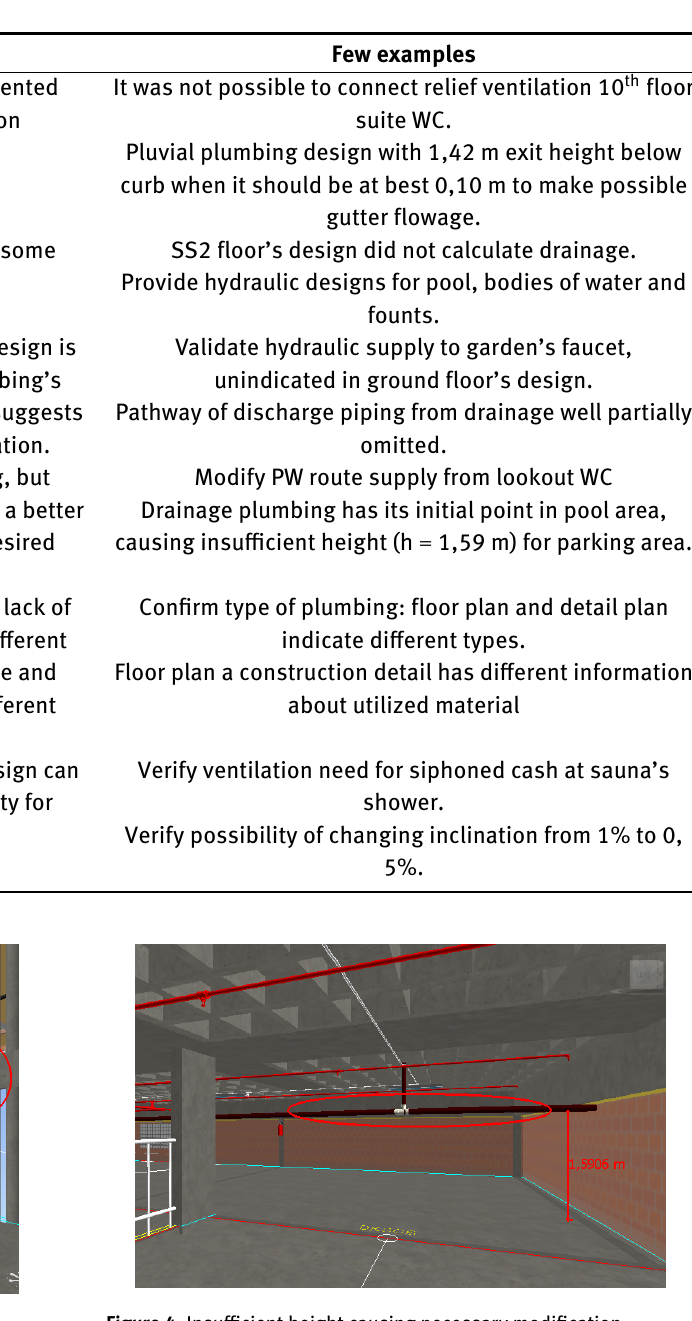
Figure 3: Difference of diameter information between plans and isometric detail drawings.